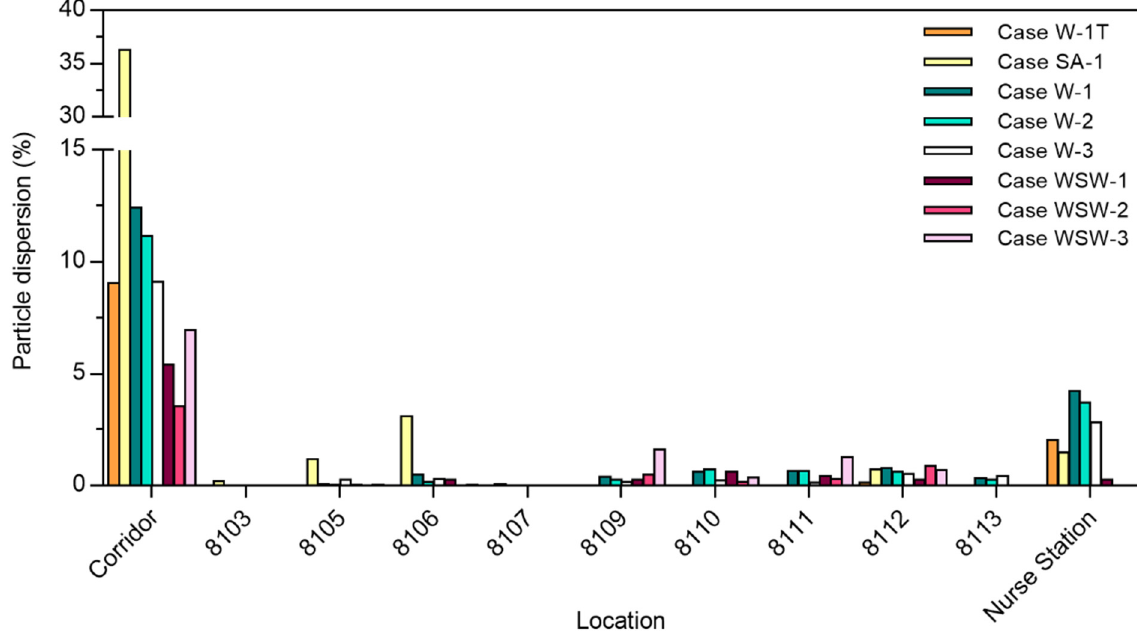
Figure 5. Particle dispersion to different wards and in the corridor.